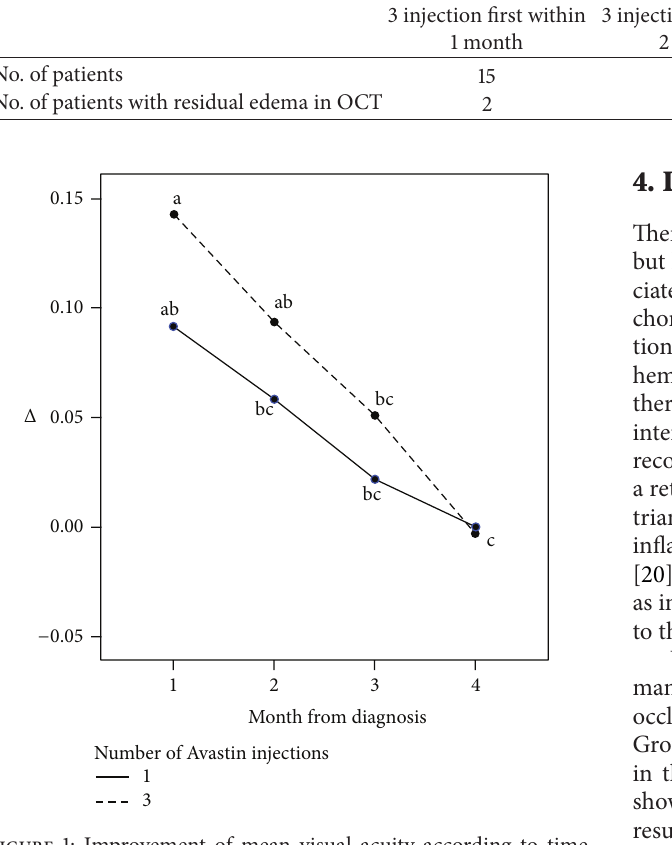
Figure 1: Improvement of mean visual acuity according to time of first injection and number of injections. Different subscripts represent statistically significant differences between the groups ( 𝑃 < 0.001 ). The 2 statistically significant results are 3 injections starting within the first month (greatest improvement) and 1 or 3 injections starting after 3 months (worst